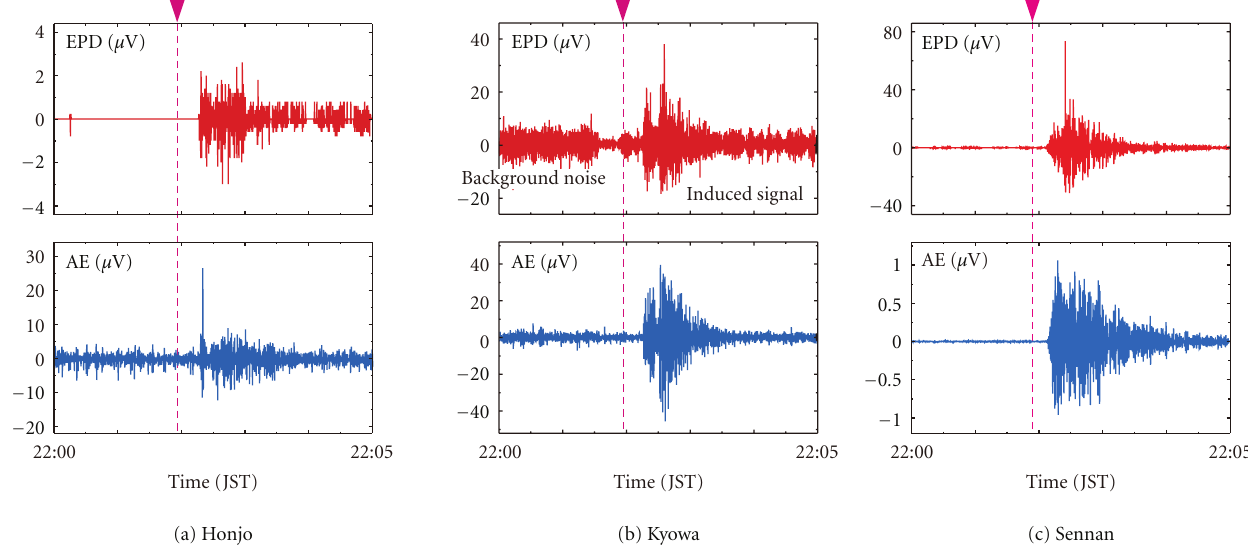
Figure 4: Waveforms extracted from raw data presented in Figure 3 using the 1 s moving average method: (a) at Honjo, (b) at Kyowa, and (c) at Sennan. Broken lines mean the origin time. The time is in JST ( = UT + 9